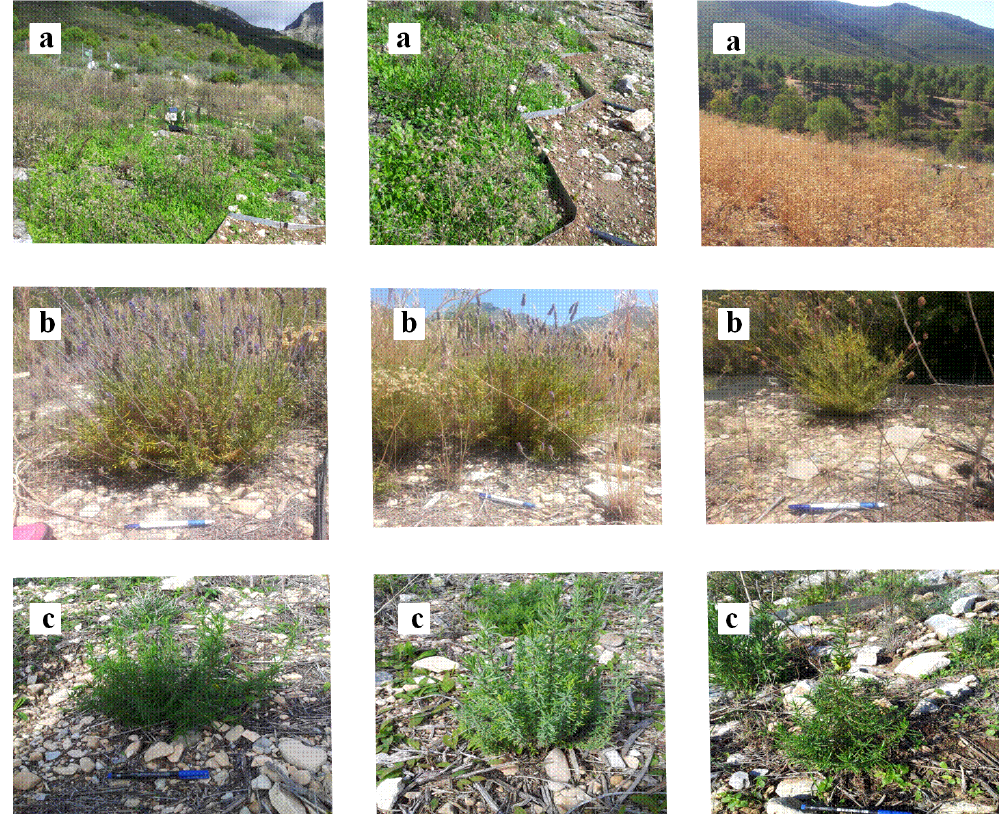
Figure 5. Photos of the experimental plots. From left to right: (a) plots amended with sewage sludge covered by Carlina hispanica Lam. in May 2012, June 2012, and September 2012, respectively; (b) Lavandula dentata individuals, June 2013, for straw mulch, pine mulch, and hy- droabsorbent polymer plots, respectively; (c) Rosmarinus officinalis individuals, June 2013, for straw mulch, pine mulch, and hydroabsorbent polymer plots, respectively. Table 3. Annual soil water content (%) at 5 and 10cm profile depths (mean, SD, coefficient of variation (CV), and maximum value (max)). The study period lasted from October 2011 to March 2014. C: soil afforested and no amendment; PM: mulch with chipped branches of Aleppo pine ( Pinus halepensis L.) ; SM: straw mulch; RU: sewage sludge; SH: sheep manure compost; HP: TerraCottem hydroabsorbent polymers. Depth 5cm (%) Depth 10cm